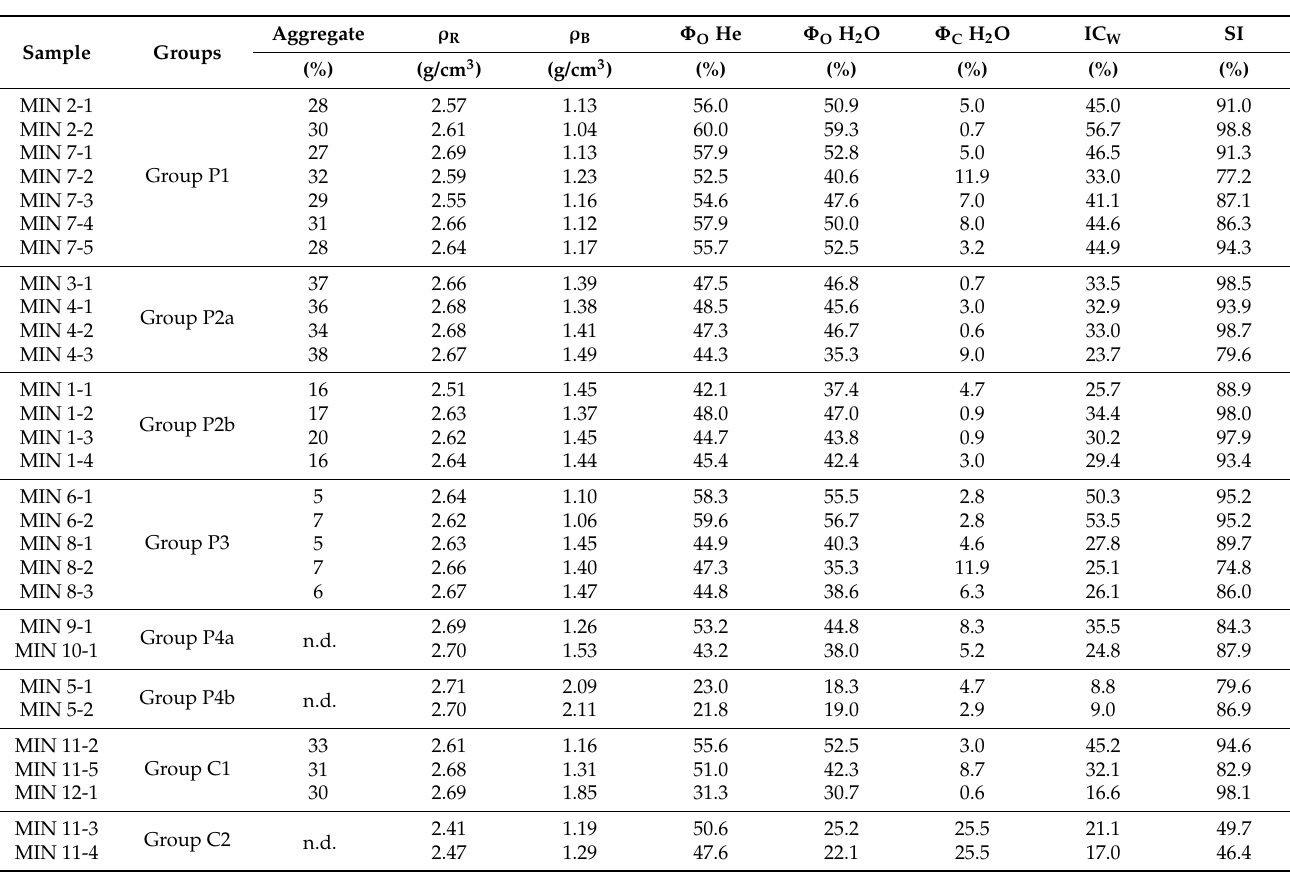
Table 3. Physical properties of samples taken from Area B and house-fort of Cap de Forma archaeolog- ical